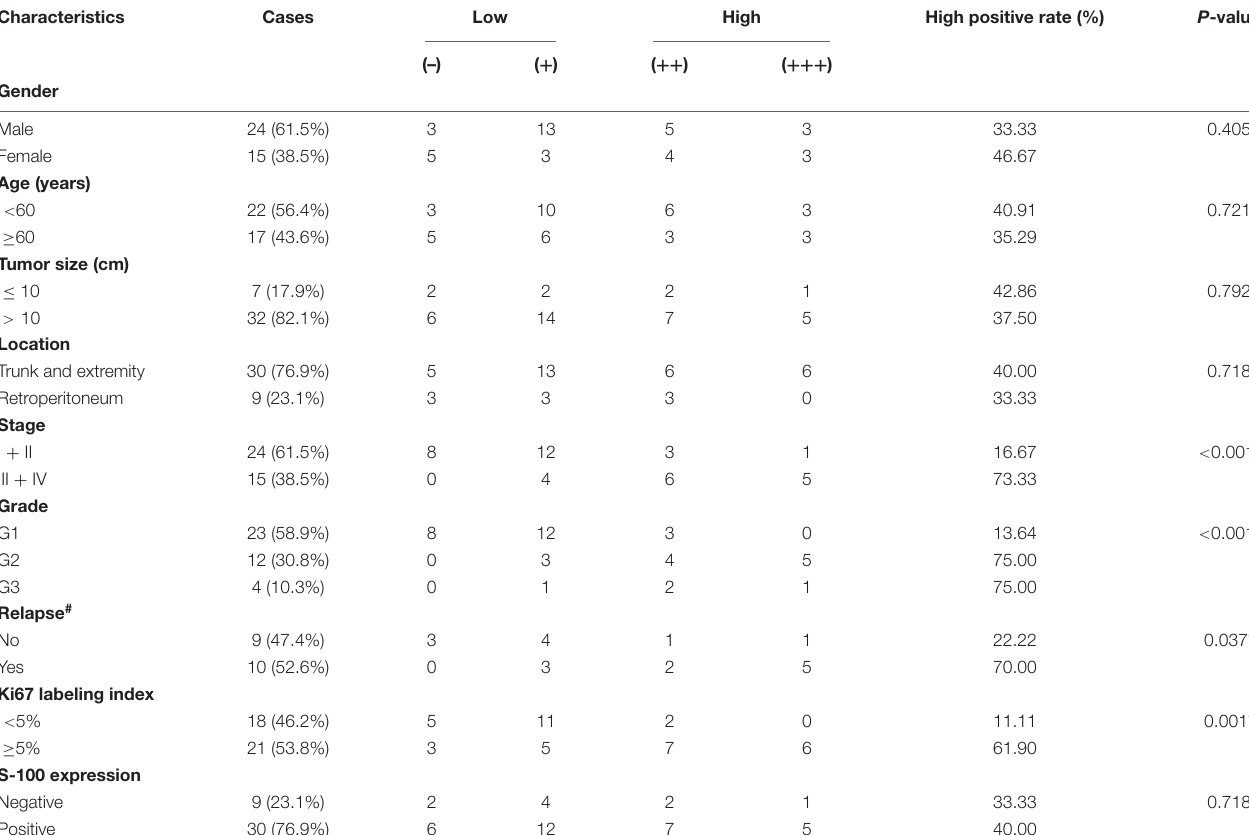
TABLE 2 | Correlation between MCM4 expression and pathological parameters in liposarcoma (LPS).